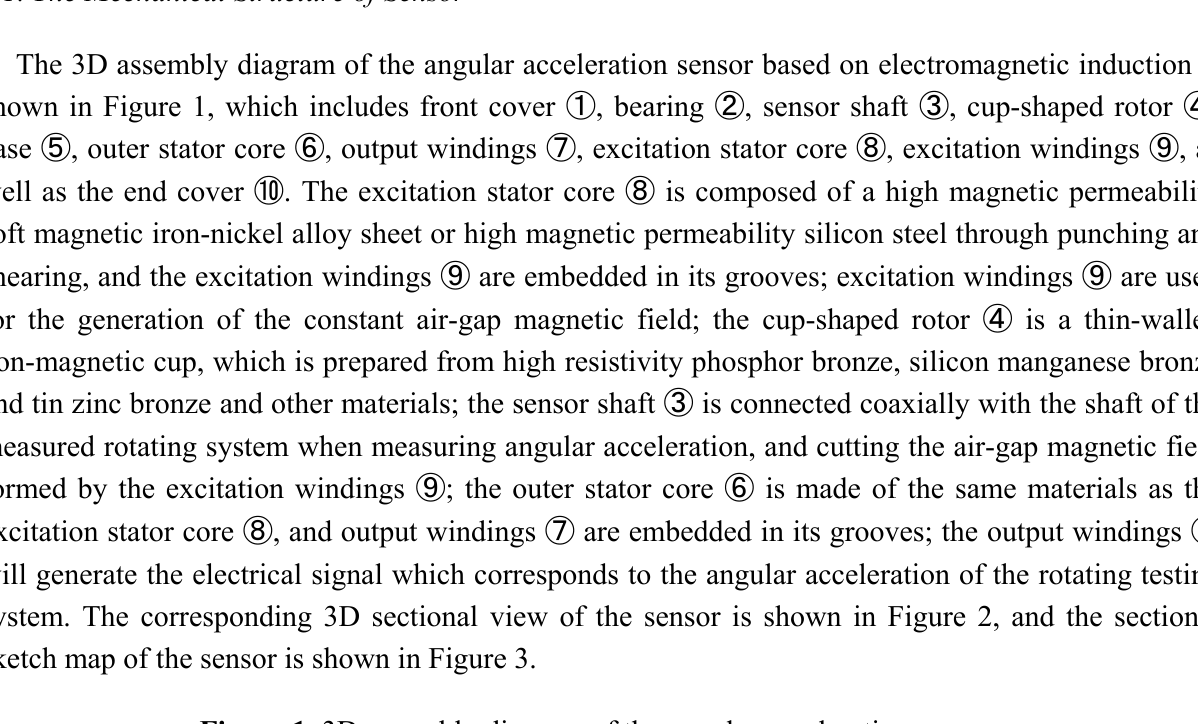
Figure 1. 3D assembly diagram of the angular acceleration